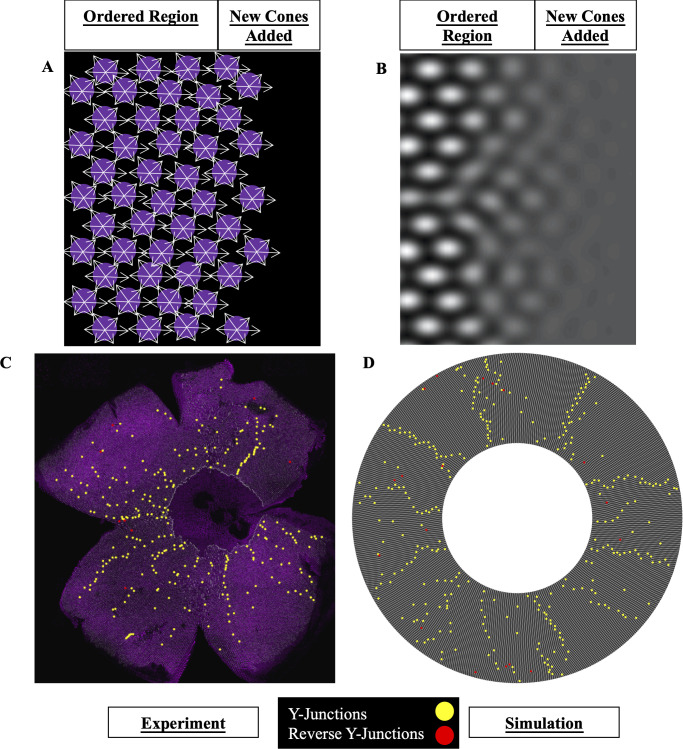
Phase-field crystal model of cone mosaic formation.(A) Schematic of contact-interaction model in which fate-committed cones interact homotypically and form an anisotropic lattice. UV cones (magenta circles) interact with nearest neighbors of same subtype. White arrows: contact interactions. New fate-committed cones are incorporated to right of the ordered region. (B) In the phase-field crystal model, a continuum field describes the positions of UV cones. UV cones are most likely to be found around peaks in the density (white regions) and least likely to be found in troughs (dark regions). (C) Flat-mounted retina (same as Fig 3A and 3B) in which UV cones express a transgenic reporter under control of the UV cone opsin promoter. Yellow dots: Y-Junctions. Red dots: reverse Y-Junctions. (D) Simulation of phase-field crystal model on the surface of a cone. The number of initial rows and total number of columns are comparable to those in retinae, and this leads to a defect density similar to that measured in experiments. The degree of anisotropy of the triangular lattice is constrained by the anisotropy in unit cell dimensions measured in our live-imaging experiments. Yellow dots: Y-Junctions. Red dots: reverse Y-Junctions.